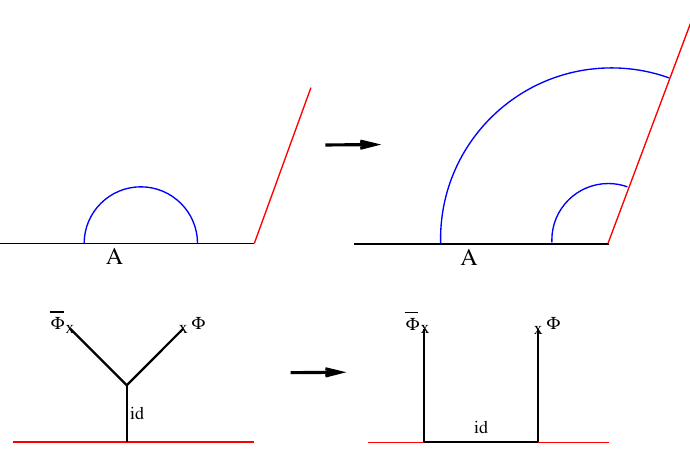
Figure 1 . Top: transition in the RT surface from connected to disconnected topology; in black hole applications, the latter is associated with an entanglement wedge that includes the black hole interior. Bottom: BCFT interpretation in terms of the two-point function of twist operators used to compute entanglement entropy via the replica method. Phase transition comes from a switch of dominance between the identity block in a bulk channel to the identity block in a boundary